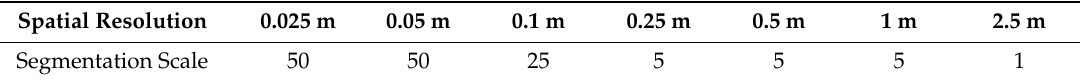
Table 4. Scale parameters for first segmentation of multi-scale